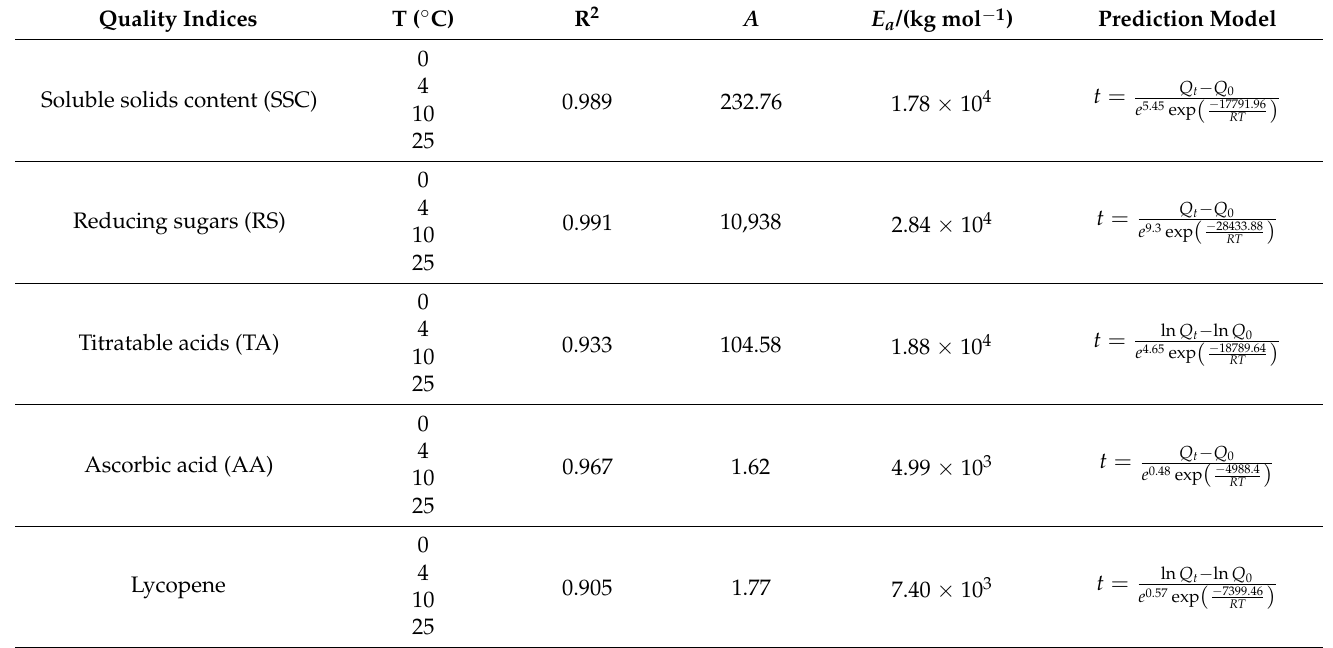
Table 2. Kinetic model of nutritional quality degradation of cherry tomatoes at different storage